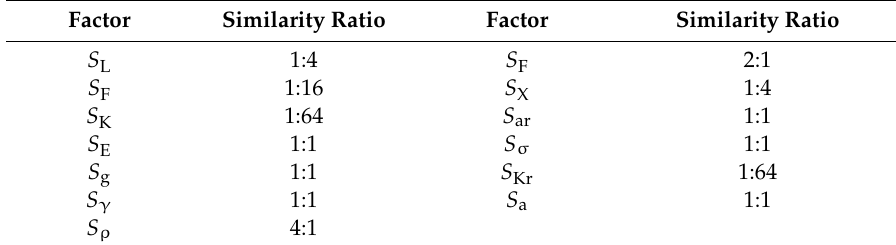
Table 2. Similarity ratio of each factor.